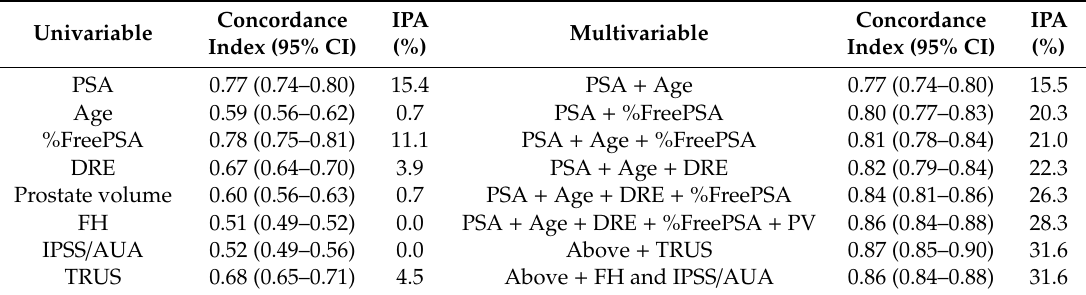
Table 2. Concordance index corrected for optimism and index of prediction accuracy (IPA) for individual and combined predictive performance for each variable of the risk calculator predicting prostate cancer with Gleason ≥ 3 + 4 in 3616 men from the